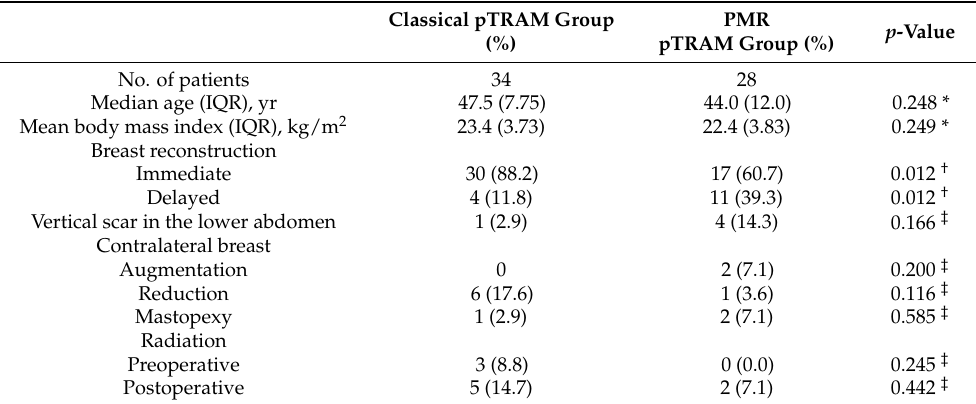
Table 1. Patient demographics.